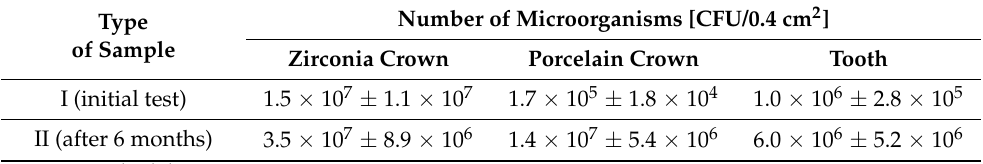
Table 1. The average concentration of microorganisms on the zirconia crowns, porcelain crowns and on the teeth surface with the interval of 6 months (detected by the culture dependent technique). Type